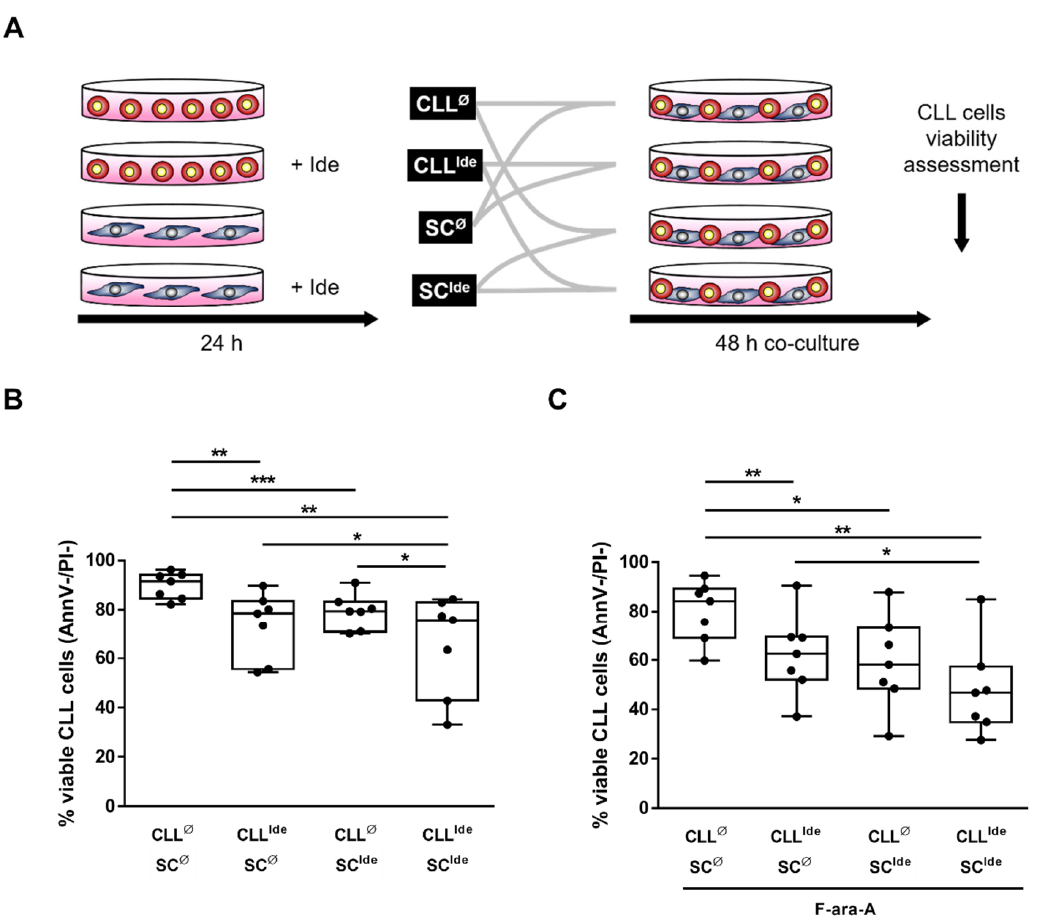
Figure 5. Idelalisib overcomes SC-mediated CLL cell protection bilaterally, acting at the leukemic cell- and SC-level. A schematic representation of the experiment design is depicted in ( A ). CLL cells and M2-10B4 SC were left untreated (CLL Φ and SC Φ ) or exposed to idelalisib (CLL Ide and SC Ide ) for 24 h, washed, and then co-cultured in different combinations (CLL Φ + SC Φ , CLL Ide + SC Φ , CLL Φ + SC Ide , CLL Ide + SC Ide ) for an additional 48 h, with or without fludarabine (F-ara-A). The final CLL cell viability was evaluated. Pretreatment with idelalisib of CLL cells, SC or both, significantly reduced the cell viability compared to the untreated combination, both in the absence ( B ) and in the presence of fludarabine ( C ). Box and whiskers plots represent median values of alive cells percentages, considered as Ann-V-negative and PI-negative (AnnV-/PI), 25–75% percentiles and minimum and maximum values for each group; each point represents a single sample value ( n = 7). *** p < 0.001, ** p < 0.01 and * p <